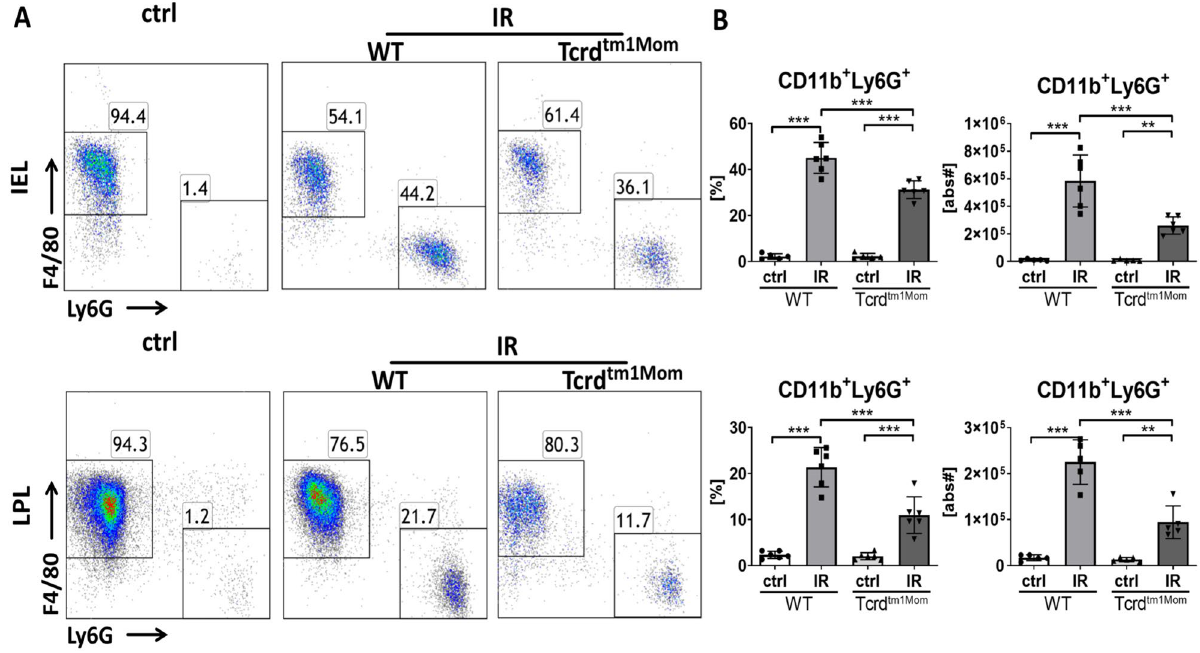
Figure 2. Neutrophil influx into the gut epithelium and lamina propria is reduced in γδ T cell deficient mice. Intraepithelial leukocytes (IEL) and lamina propria leukocytes (LPL) were isolated from small intestines and at least 1 × 10 5 leukocytes per sample analyzed by flow cytometry in wild-type (WT) mice and mice deficient of γδ T cells (Tcrd tm1Mom ) after intestinal ischemia reperfusion (IR) or sham operation (ctrl). (A) Flow cytometry of live CD45 + CD11b + leukocytes in IEL (upper row) and LPL (lower row) showed an increase of Ly6G + neutrophils following IR, which is reduced in γδ T cell deficient mice compared to WT mice. (B) Percentage of CD11b + myeloid cells among IEL (upper graph) and LPL (lower graph) in WT and Tcrd tm1/mom following IR or ctrl treatment. Each data point represents the result of the analysis of an individual mouse. Bars represent group mean and error bar depicts ± SD. N = 6/group. ns not significant. ***p < 0.001. Data are representative of two independent